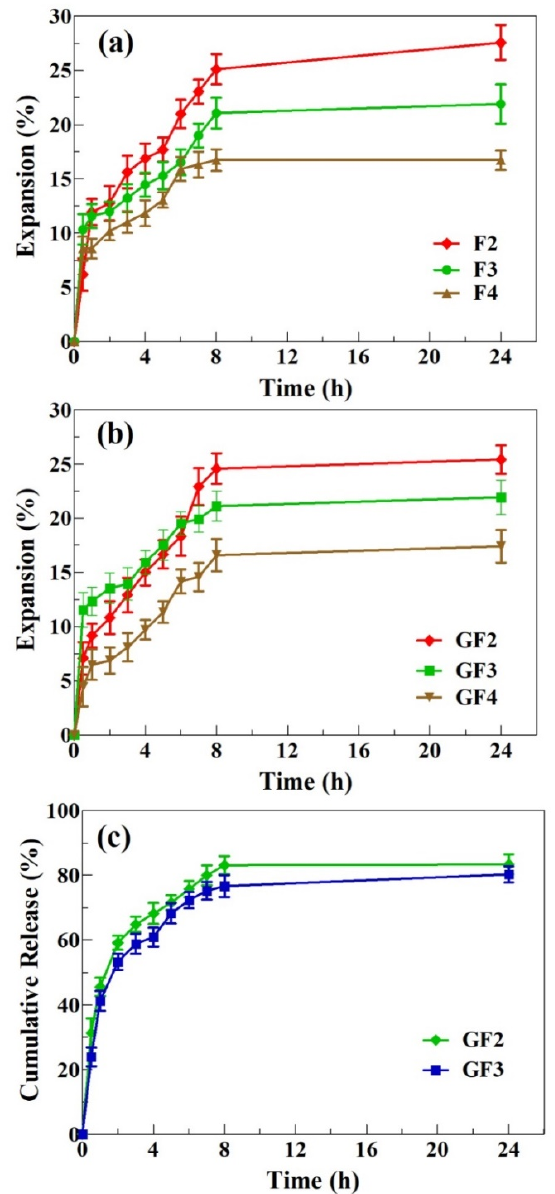
Figure 5. Expansion profiles of blank ( a ) and GS-loaded ( b ) AXSA films; and ( c ) drug release profile (mean ± SD, n = 3).